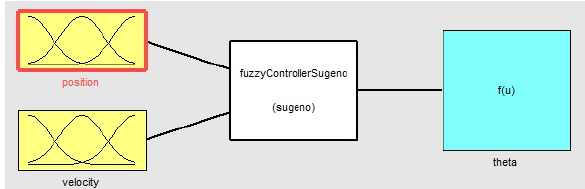
Figure 11: Fuzzy Logic Sugeno.